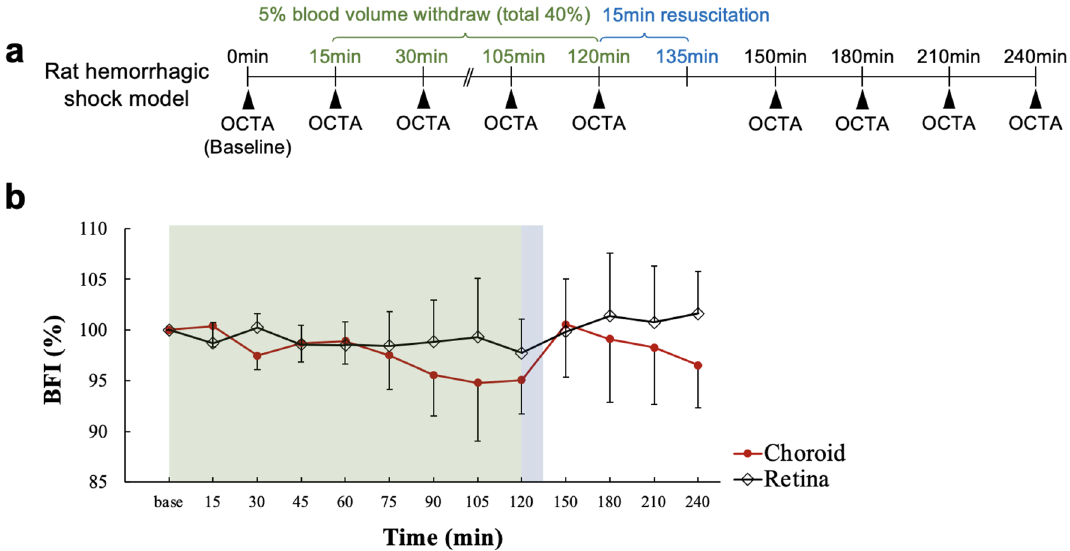
Figure 3. Blood flow change in rat hemorrhagic shock model. In order to simulate hemorrhagic shock in the rat, 5% of blood volume was withdrawn eight times with a 15-min interval in the first two hours and then resuscitation was performed for 15 min. OCTA imaging was performed right after every blood withdrawal and every 30 min for 1.5 h after resuscitation ( a ). ( b ) Shows time versus BFI values (mean ± SD, n = 5) of the retinal and the choroidal flows. Changes in BFI, MAP, and lactate are summarized in Table 2.